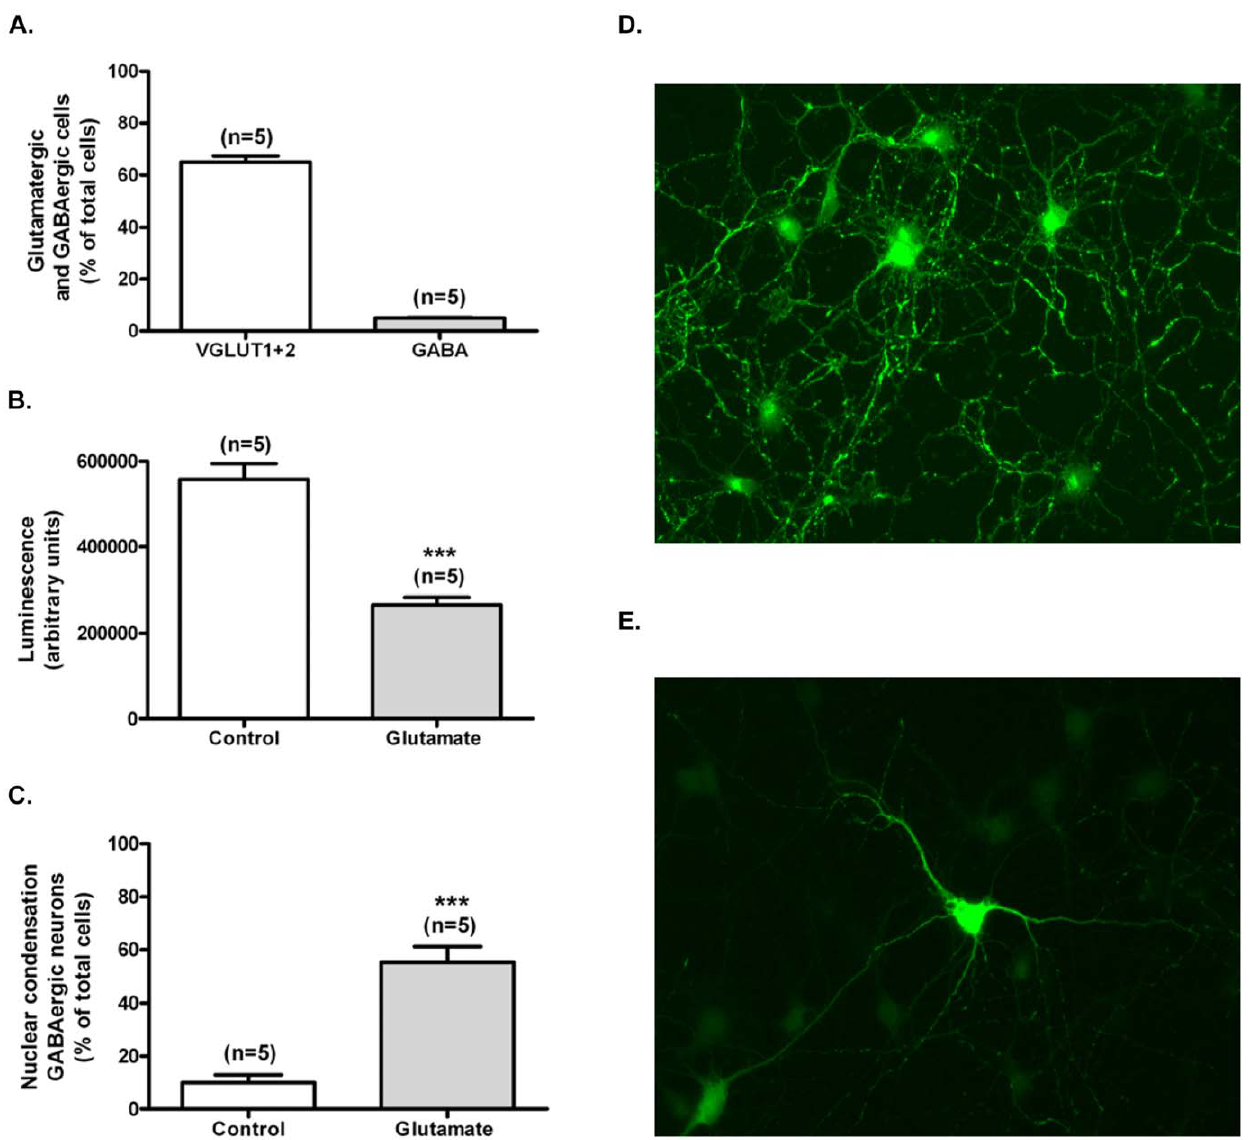
Figure 1. Glutamate excitotoxicity decreases viability of cultured hippocampal GABAergic neurons. GABAergic and glutamatergic neurons in the cultures (DIV7) were identified by immunocytochemistry, using antibodies against GABA (A, E) and VGLUT1 + 2 (A, D). The total number of cells present in the analysed fields was calculated based on the number of nuclei, stained with the fluorescent dye Hoechst 33342. Data are presented as mean 6 SEM of 5 independent preparations (A). Excitotoxic stimulation of hippocampal neurons was performed by incubation with 125 m M glutamate, for 20 min, in fresh Neurobasal medium containing B27 supplement, and the cells were further incubated in the original medium for 14 h. Cell death was assessed with the recombinant Luciferase chemoluminescence assay with CellTiterGlo (B), or by fluorescence microscopy using the fluorescence dye Hoechst 33342 (C). In the latter condition GABAergic cells were identified by immunocytochemistry, using an antibody against GABA. Data are presented as mean 6 SEM of 5 independent experiments. Statistical analysis was performed using Student’s t - test. *** p , 0.001.